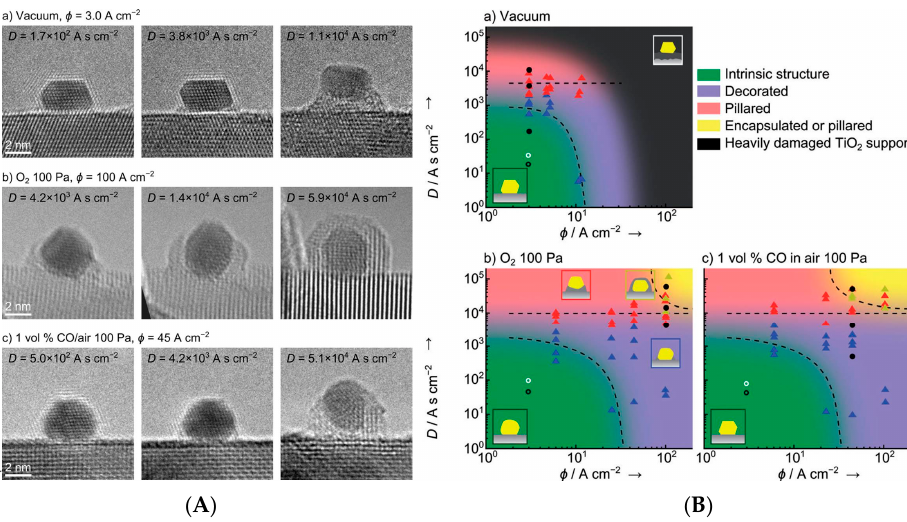
Figure 21. Au/TiO 2 nanoparticles changes under e-beam exposition: ( A ) Structural reorganisation of Au/TiO 2 nanoparticles under e-beam irradiation in vacuum, O 2 environment (100 Pa) and CO environment (1 vol% CO in air 100 Pa). D corresponds to the electron dose and φ to the electron current density; ( B ) Structure evolution diagram of Au/TiO 2 nanoparticles under e-beam showing the regions for the formation of decorated, pillared and encapsulated nanoparticles as a function of D and φ . The intrinsic structure can be extrapolated for D and φ = 0. Reproduced from [253]. Copyright 2012, Wiley-VCH Verlag GmbH & Co. KGaA, Weinheim.